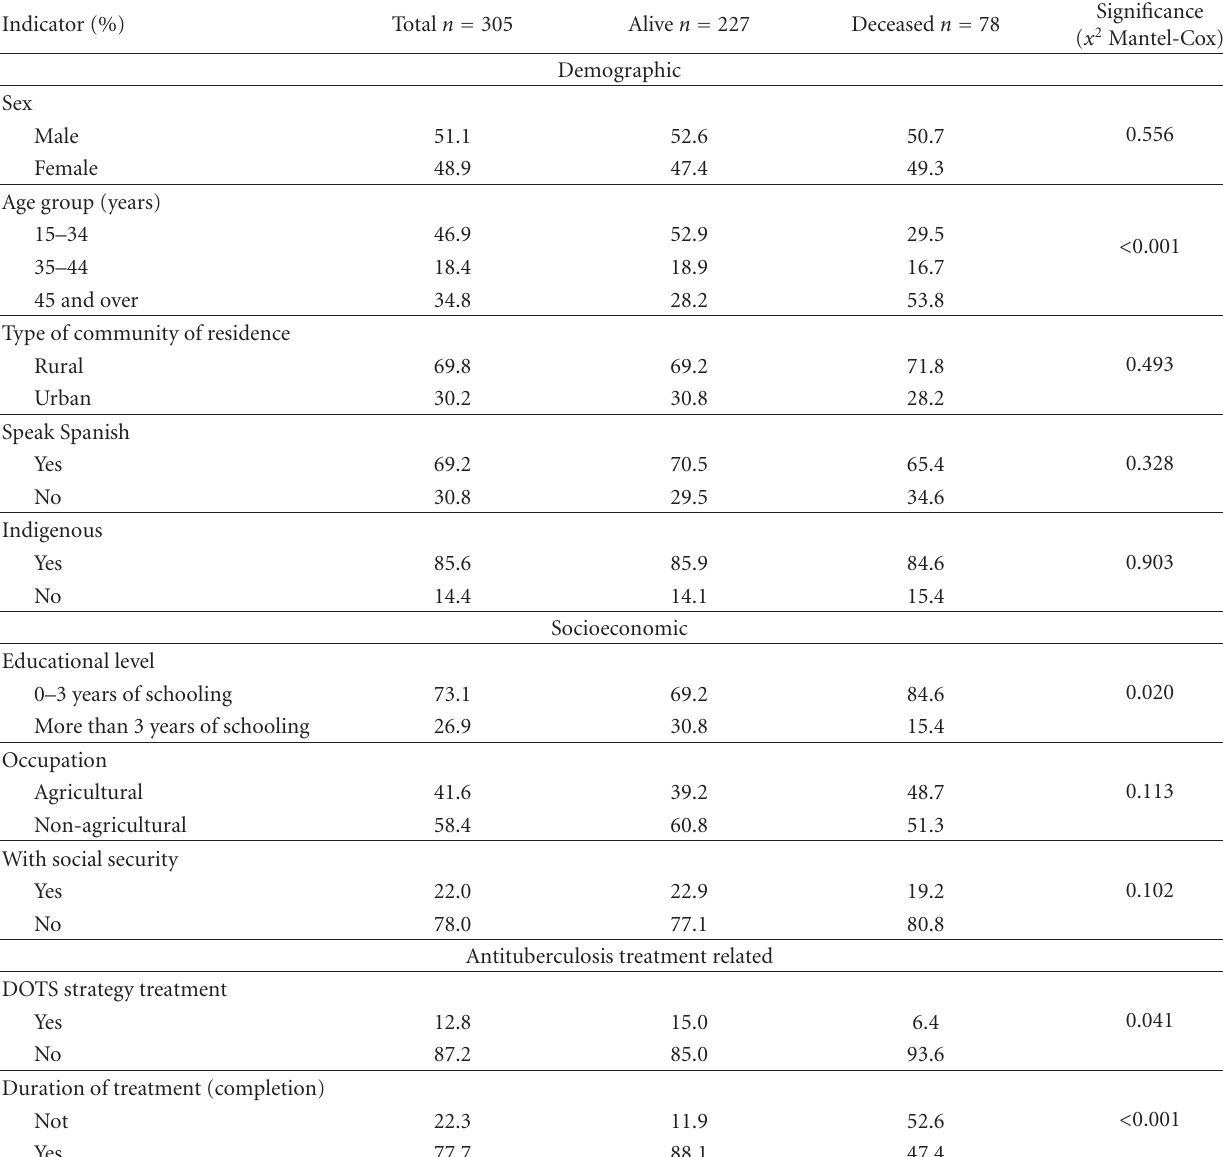
Table 1: Demographic, socioeconomic, and antituberculosis treatment-related indicators among the study patients. Indicator